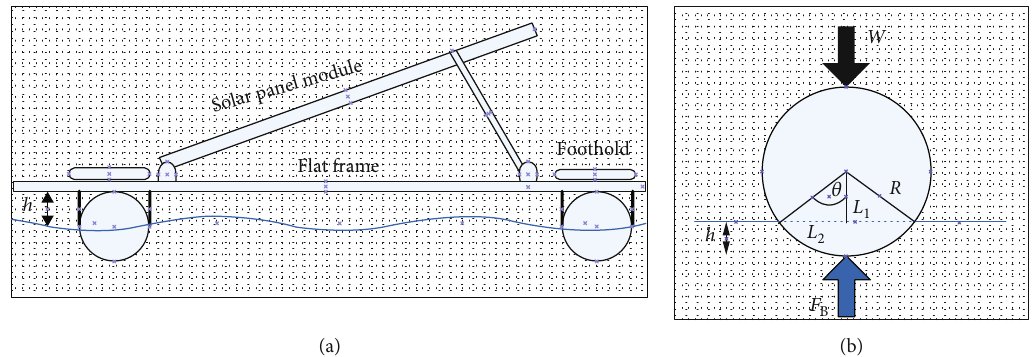
Figure 19: (a) Illustration of mounting racks carried by pipe pontoons. (b) Parameters used to calculate the bounce force in Ex.1.